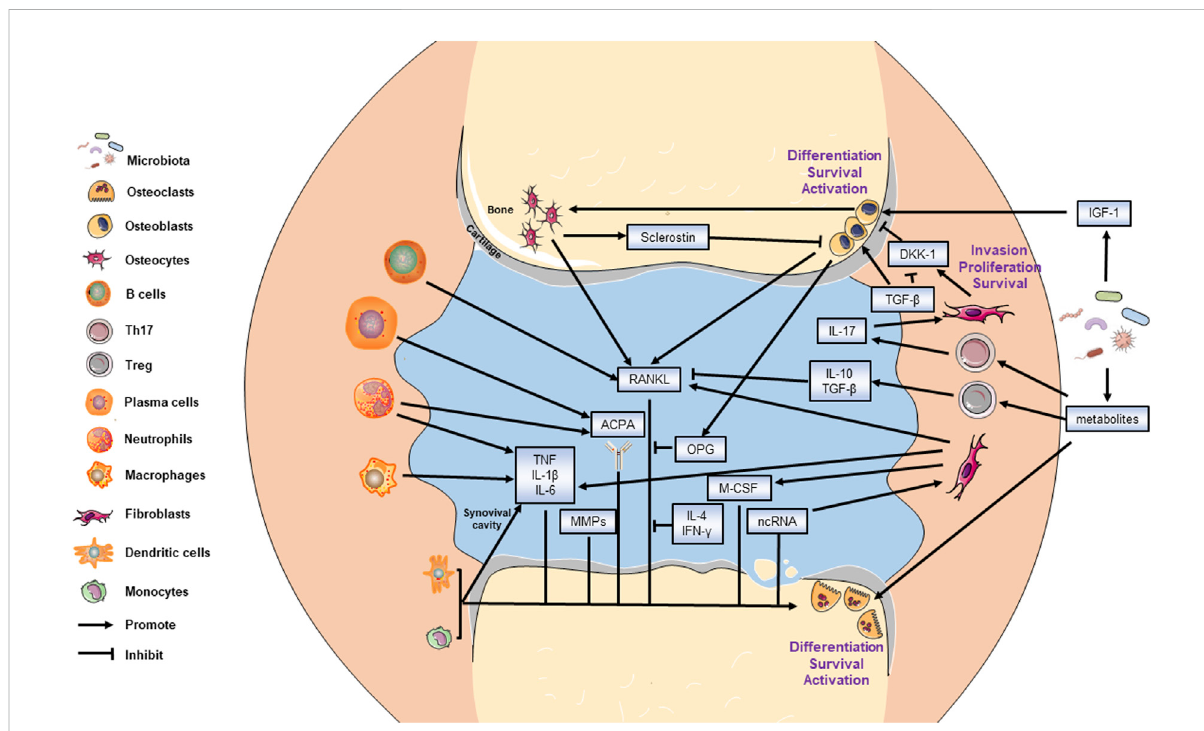
FIGURE 1 Mechanism of bone metabolism in RA. All targeted cells and cytokines are labeled. The bone resorptive activity is balanced by osteoblasts and osteoclasts.Theinvasionof fi broblastsalsoleadstobonedestruction.Thearrowendrepresentspromotioneffectwhilethebluntendrepresentsthe inhibitory